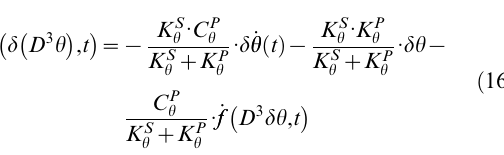
relaxes this assumption by considering the coefficients as time- varying. Figure 2b represents a linear, time-invariant, third-order system known as the Poynting-Thomson (PT) model. This mechanical network is an extension of the KV model commonly used in muscle models and includes tendon elasticity (Hill-type passive model). The PT model includes two separate elastic elements. The , in series with the muscle fibers, represents the stiffness element K S h of the tendon. The parallel between K P and C P represents the h h stiffness and viscosity of the muscle fibers. The internal viscoelatic field complies with the following differential equation: